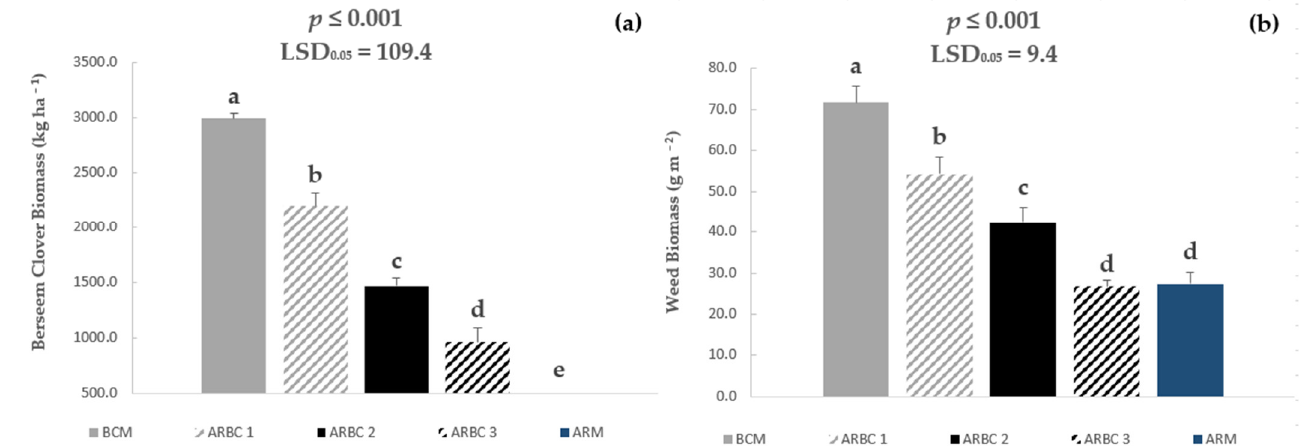
Figure 8. ( a ) Biomass of berseem clover (kg ha −1 ), and ( b ) weed biomass (g m −2 ) in the second harvest. Data were pooled over years (Y) and seedbeds (S). ARBC 1: First intercrop with